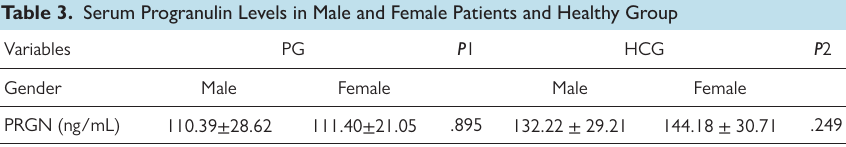
Table 3. Serum Progranulin Levels in Male and Female Patients and Healthy Group